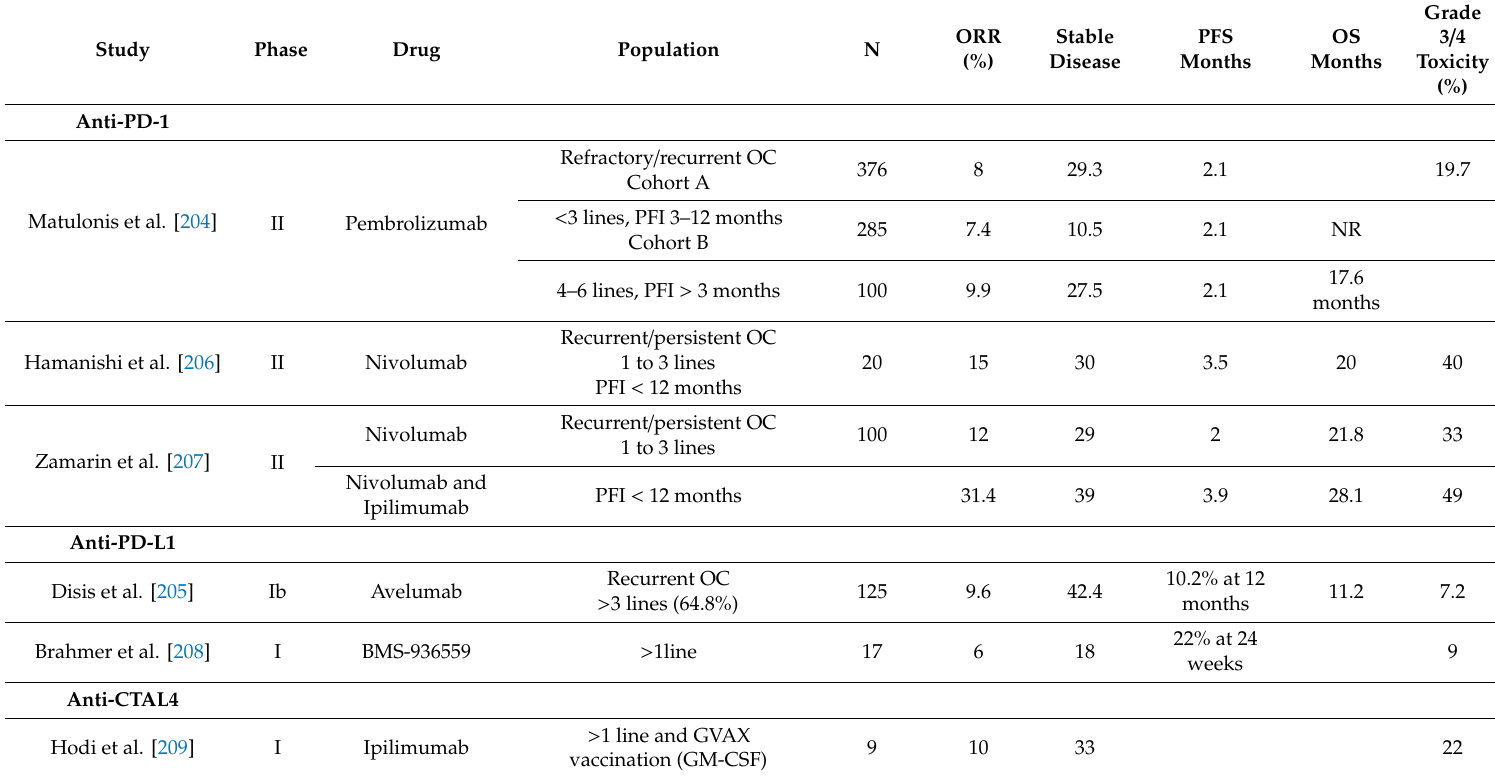
Table 1. Published results from selected ICB clinical trials for recurrent